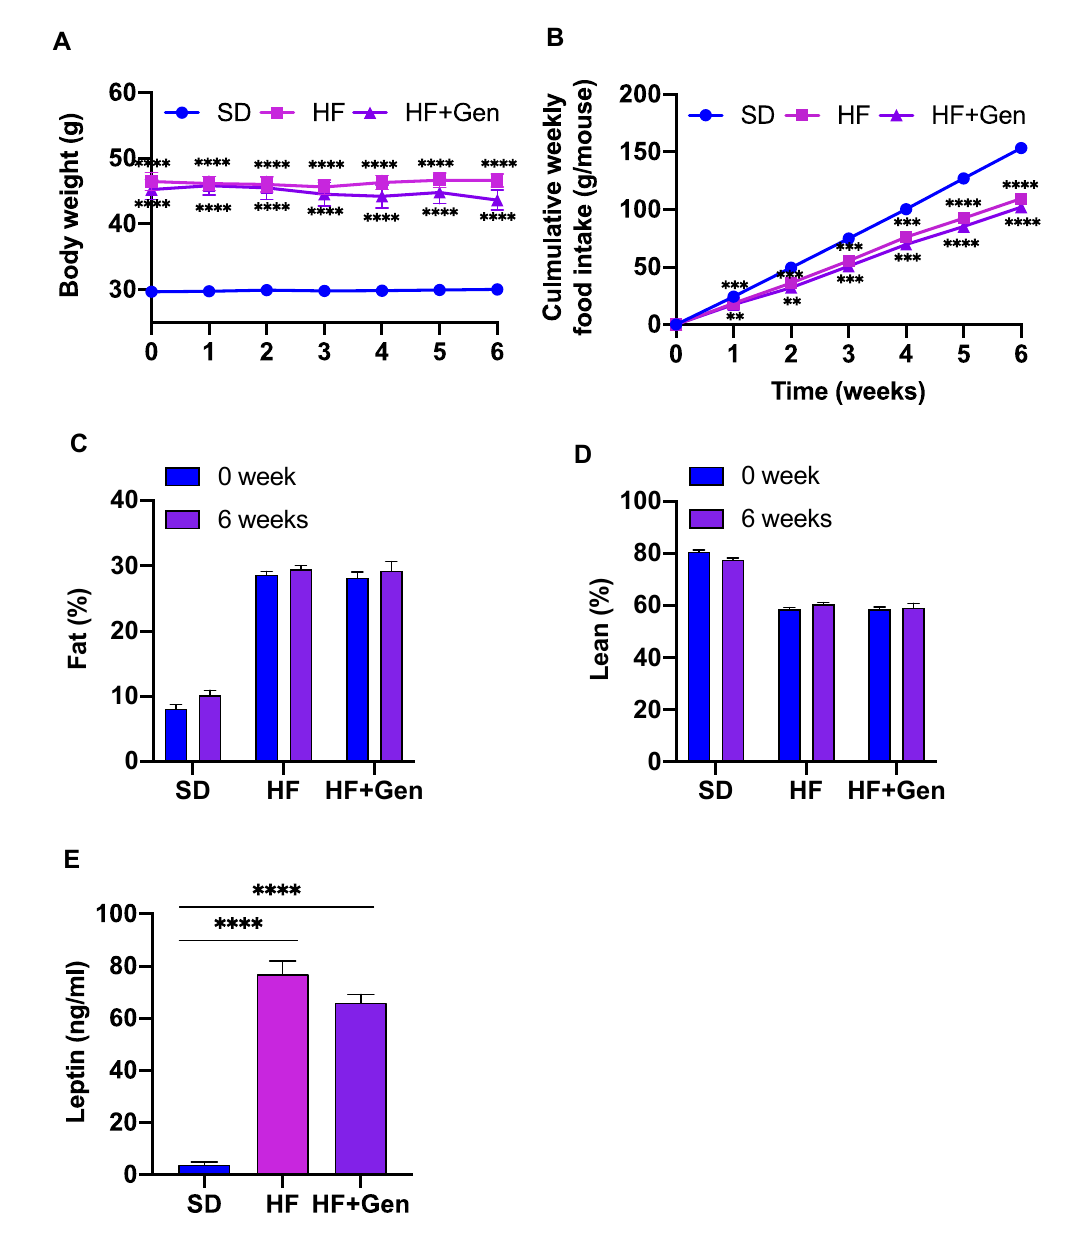
Figure 6. Genipin did not alter BW gain and food intake in obese mice. BW ( A ) and food intake ( B ) were recorded weekly. Body composition ( C , D ) was measured before and after the treatment. Blood samples were collected after treatment and plasma leptin ( E ) was determined using a commercial kit. Data are presented as mean ± SE or SEM. ** p <0.01, *** p < 0.001 and **** p < 0.0001 vs. SD. As expected, HFD feeding significantly increased triglyceride levels in obese mice compared with SD-fed mice. However, plasma and liver triglyceride contents in genipin- treated mice were almost restored to levels comparable to those in the lean mice (Figure